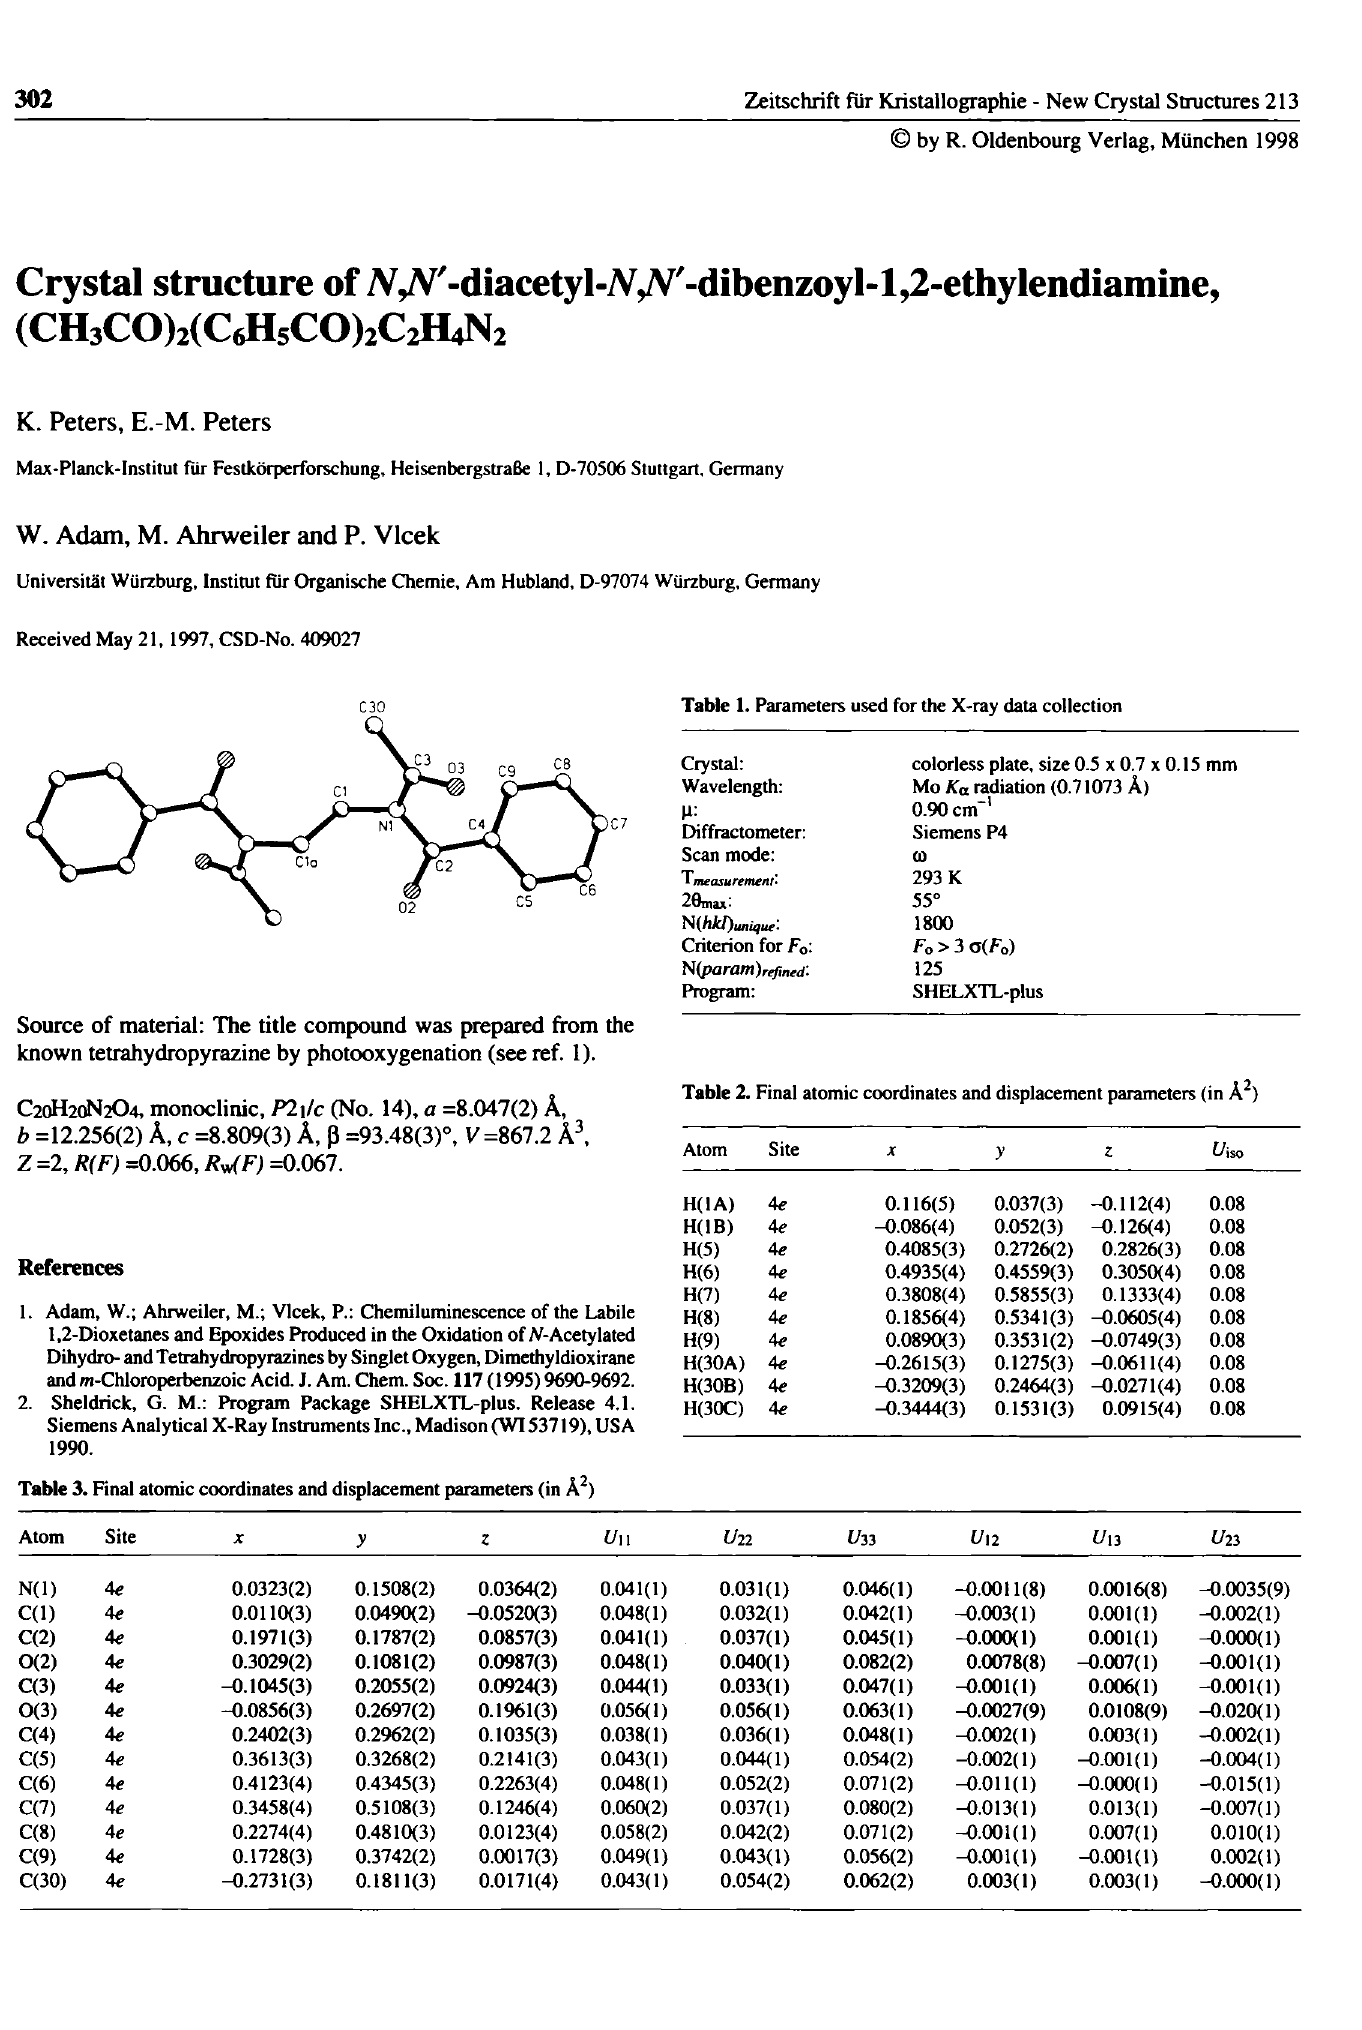
Table 3. Final atomic coordinates and displacement parameters (in Â^)